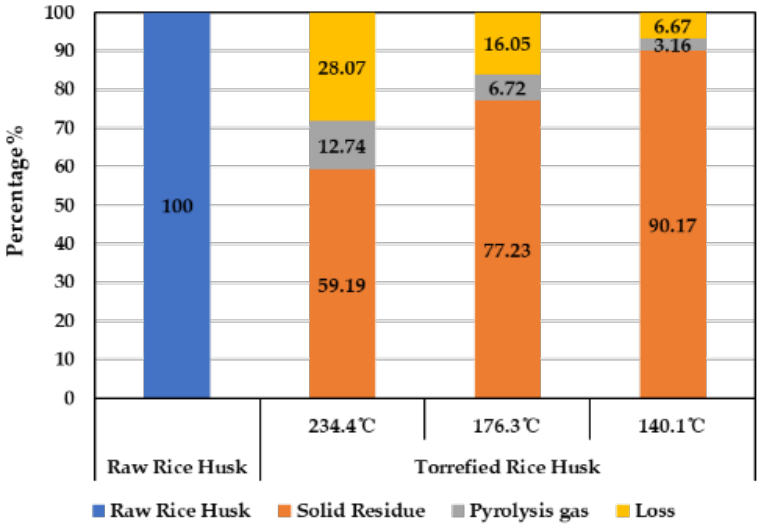
Figure 9. Energy loss of rice husk materials before and after the torrefaction process.